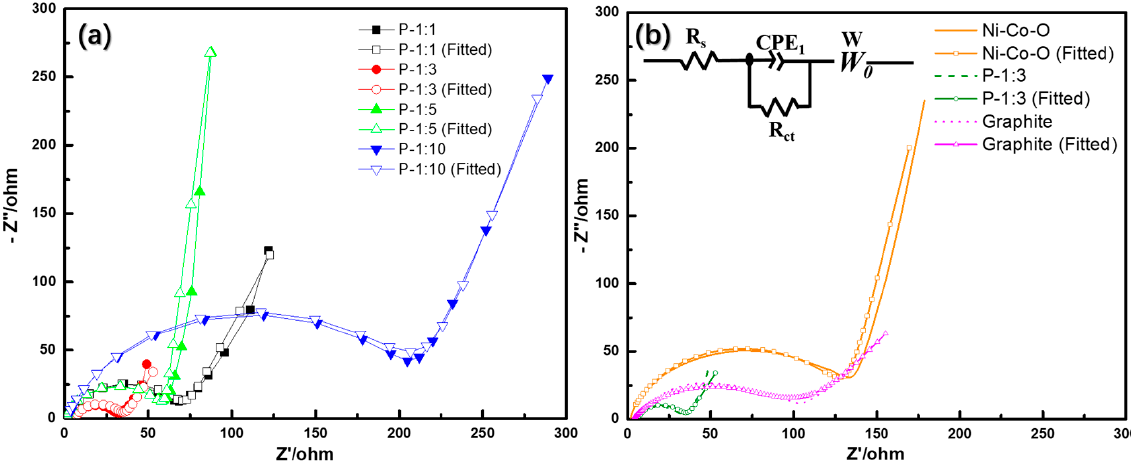
Figure 6. ( a ) Electrochemical impedance spectra (EIS) pattern of Ni-Co-P samples with different ratio from 1:1, 1:3, 1:5, to 1:10. ( b ) Comparison of EIS pattern between Ni-Co-O, P-1:3, and graphite.